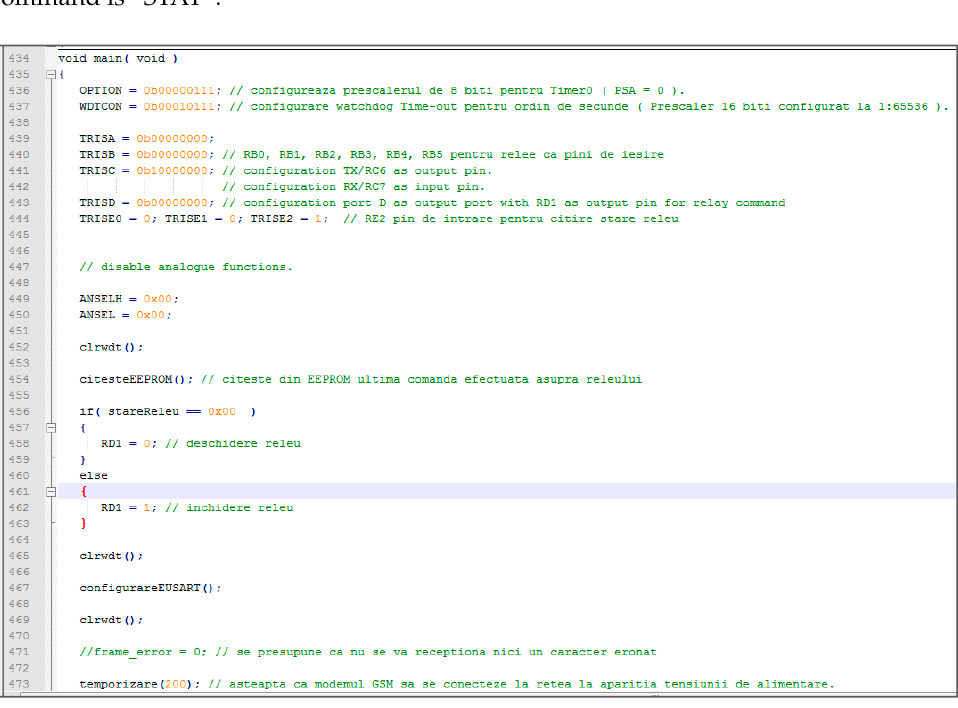
Figure 6. Main code with con fi gurations and fail-safe features.